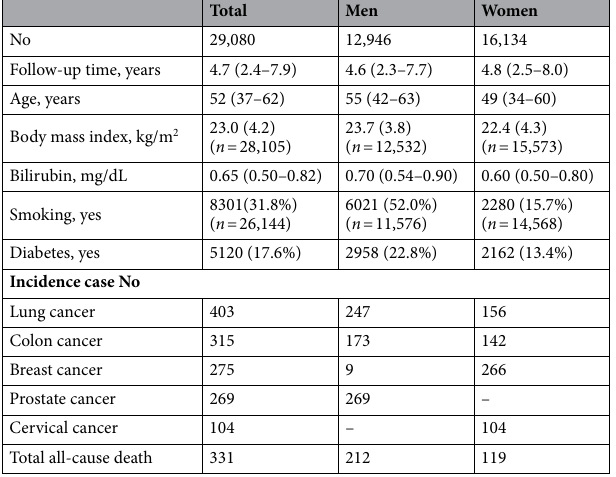
(Table 2). For bilirubin levels < 1.2 mg/dL, the analyses were performed using serum bilirubin levels as continu-